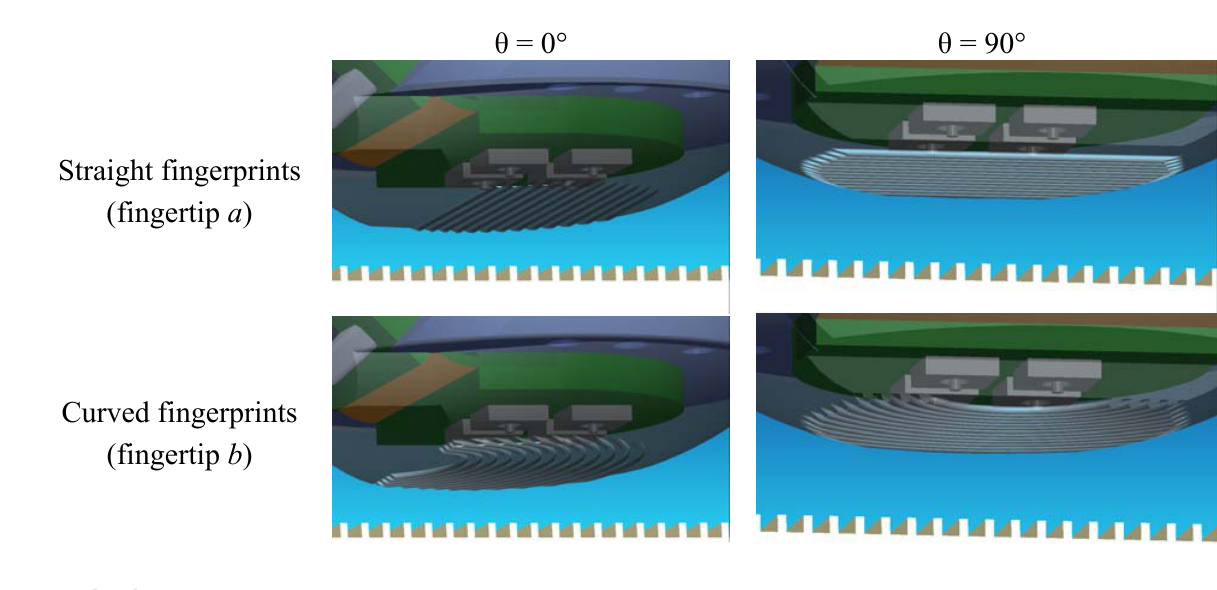
Figure 4. Protocol for the artificial touch experiments: the two biomimetic fingertip prototypes, differing in the curvature of fingerprints, were rotated in steps of 10° from θ = 0° (stimulus sliding along the distal phalanx) to θ = 90° (stimulus sliding across the distal